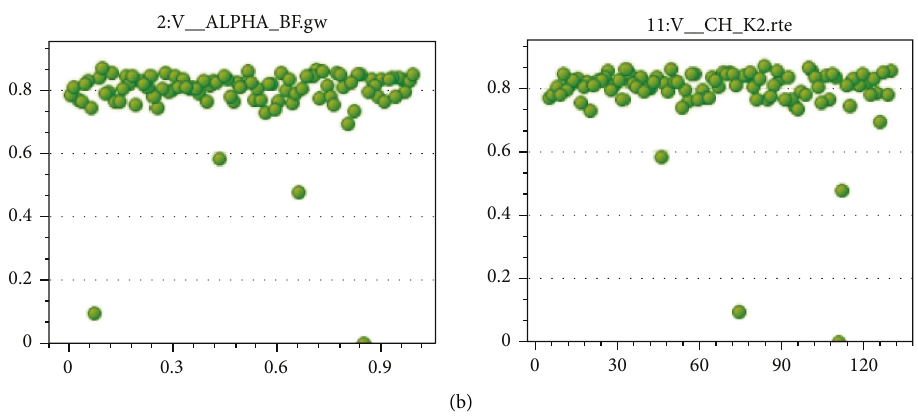
Figure 7: Daily dotty plots of the most sensitive parameters of the Nashe